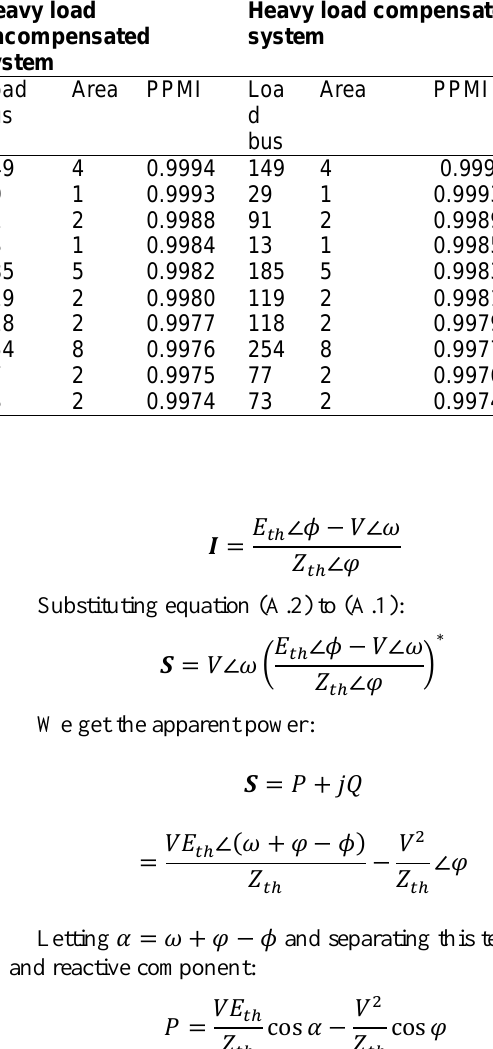
Table 5. The most stable buses under different system loading